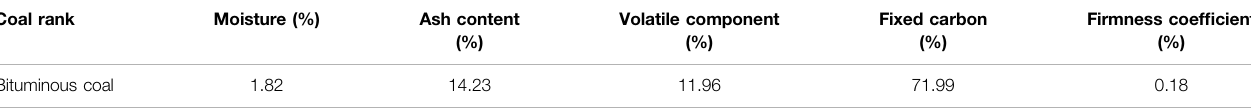
TABLE 1 | Elemental analyses and fi rmness coef fi cient of coal samples. Coal